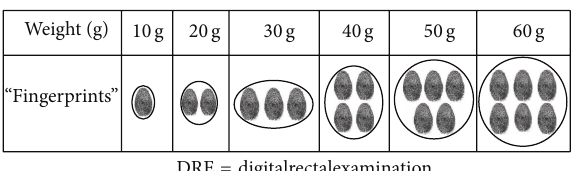
Table 1: Patients’ clinical characteristics (1cc =